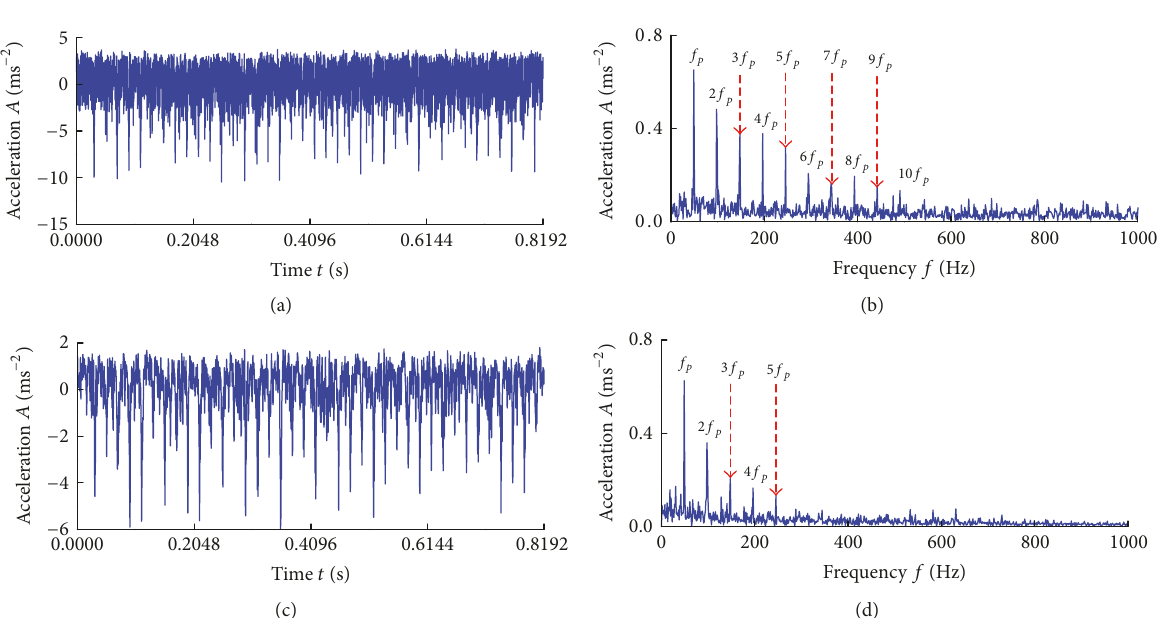
Figure 6: The intrinsic envelopes extracted by the manifold with Isomap and their envelope spectra: (a) on IMF-envelope space of EEMD, (b) the envelope spectra of (a), (c) on multiscale envelope space of WPT, and (d) the envelope spectra of